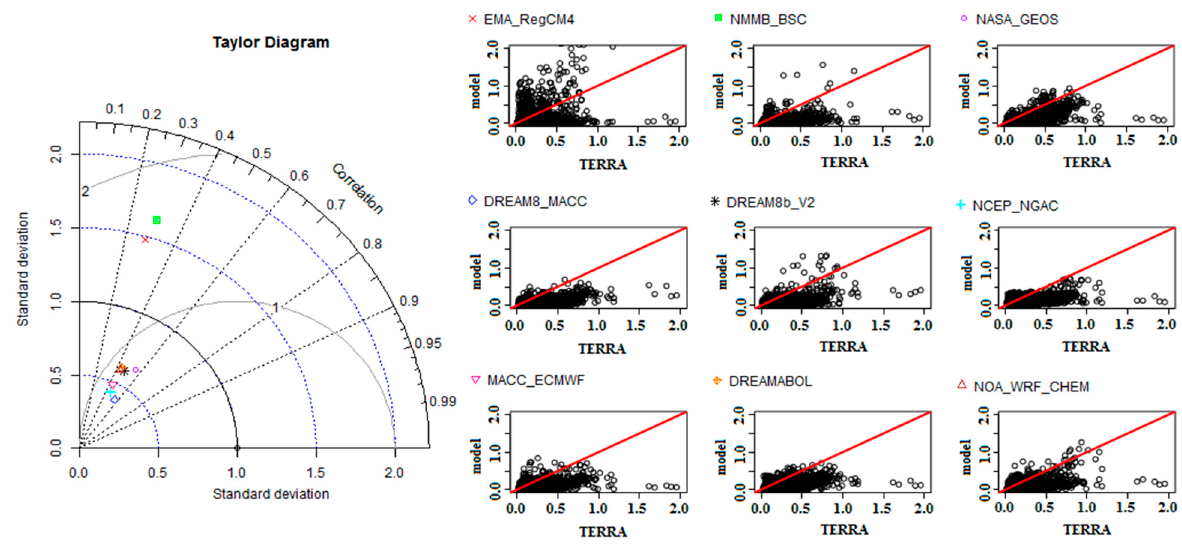
Figure 9. Taylor diagram and scatter plots of AOD values from model outputs and Terra-MODIS observations over the Middle East during post-frontal dust storms.